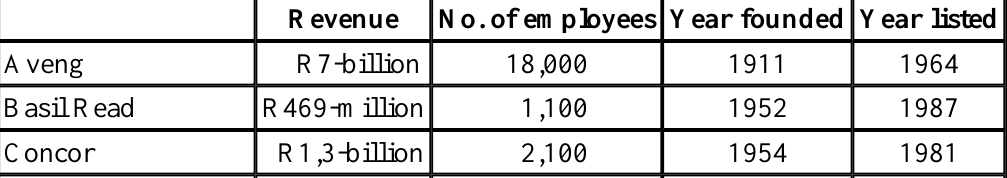
Table 1 JSE-listed construction sector companies (Source: Annual reports 2004